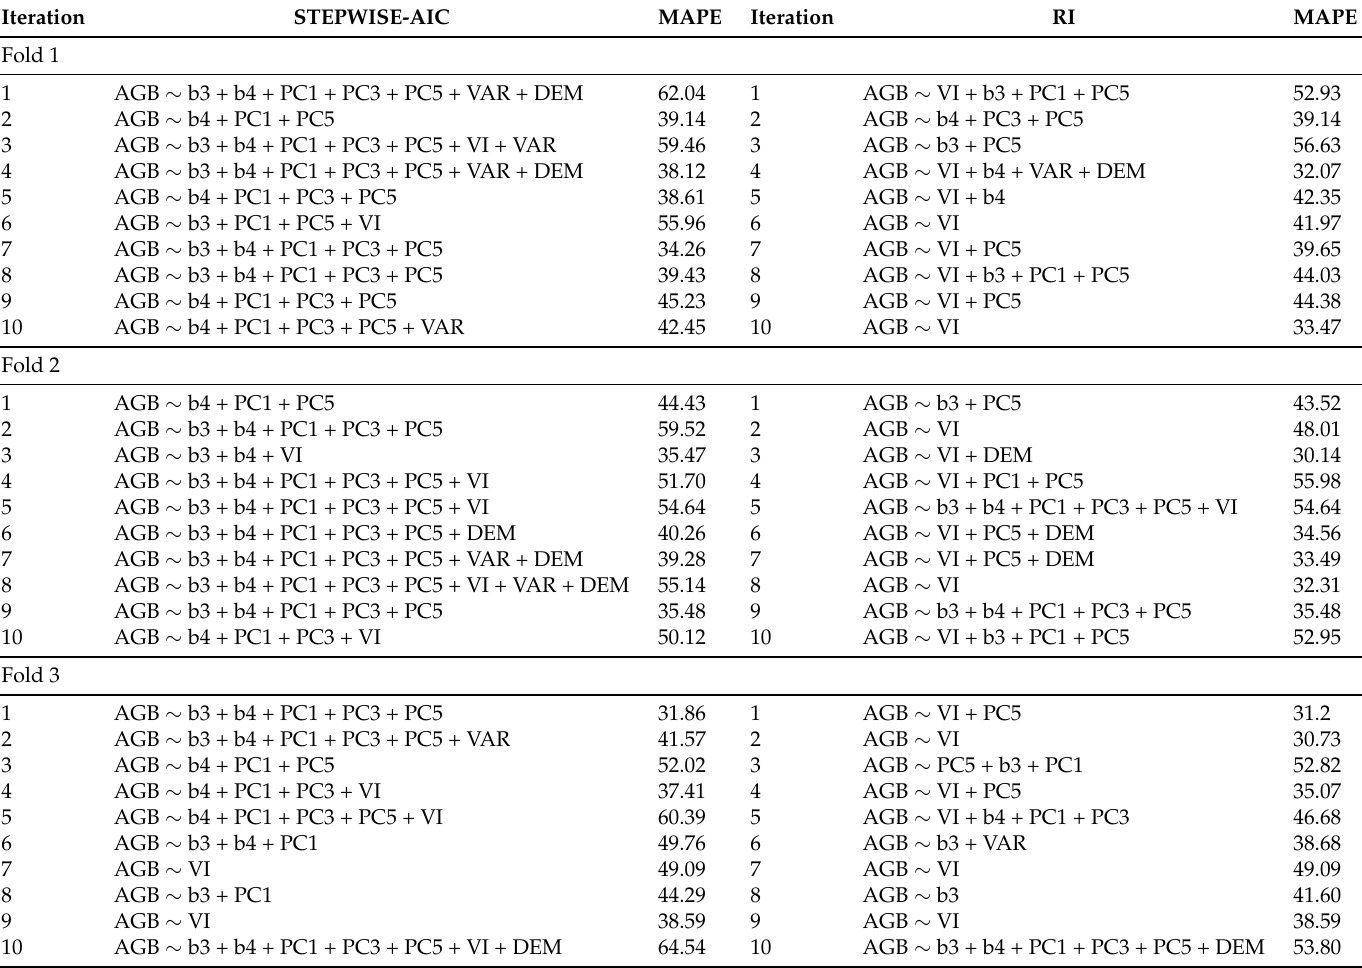
Table 8. Regression models generated with STEPWISE-AIC and RI in the triple cross validation and corresponding MAPE for the RapidEye image.